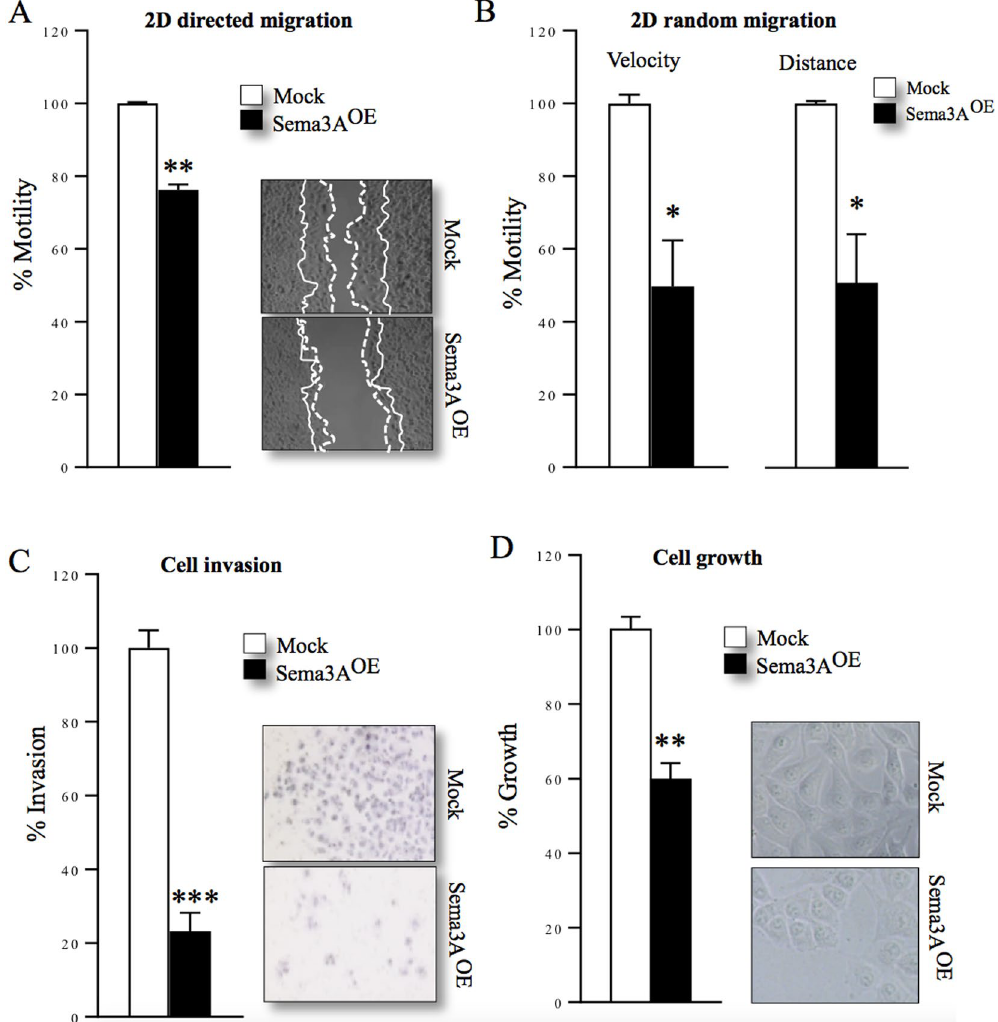
Figure 2. Osteosarcoma-derived Sema3A reduces motility, invasion and growth of KHOS cells. In vitro 2D directed ( A ) and random ( B ) cell migration of human KHOS cells overexpressing Sema3A (Sema3A OE ) or mock control after 4 and 8 hours as assessed by wound healing and individual cell tracking, respectively. Representative photomicrographs from the 2D directed migration experiment described are shown in panel A, right. ( C ) In vitro cell invasion of human KHOS cells overexpressing Sema3A (Sema3A OE ) or mock control after 72 hours as assessed by Transwell Chamber assay. Representative photomicrographs from the experiment described are shown in the right. ( D ) In vitro cell growth of human KHOS cells overexpressing Sema3A (Sema3A OE ) or mock control in the absence of fetal calf serum after 48 hours as assessed by AlamarBlue assay. Representative photomicrographs from the experiment described are shown in the right. A line represents cell front at 0 hours, dotted line represents cell front at 4 hours. Data are mean ± SEM, n = 3 * p < 0.05, ** p < 0.01 *** p <